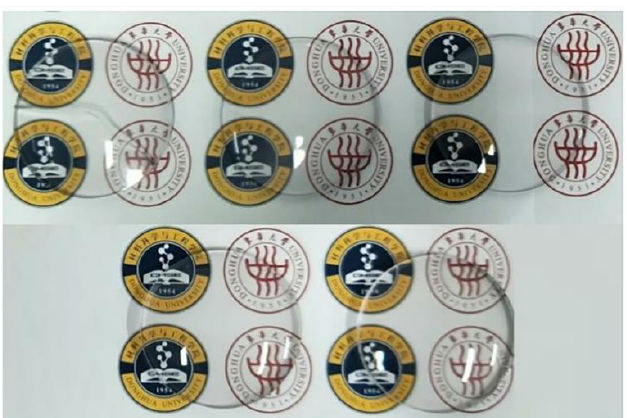
Figure 15. High and low temperature test diagram of coating (Note: the order of lens placement is the same as Figure 14).